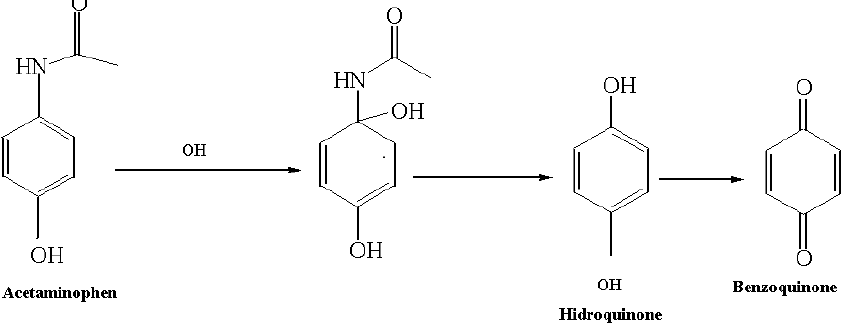
Figure 8. Major organic products (OIP) determined by co-injection of standards with liquid chromatography on the degradation of acetaminophen in an RFR reactor with titanium-silver catalysts.